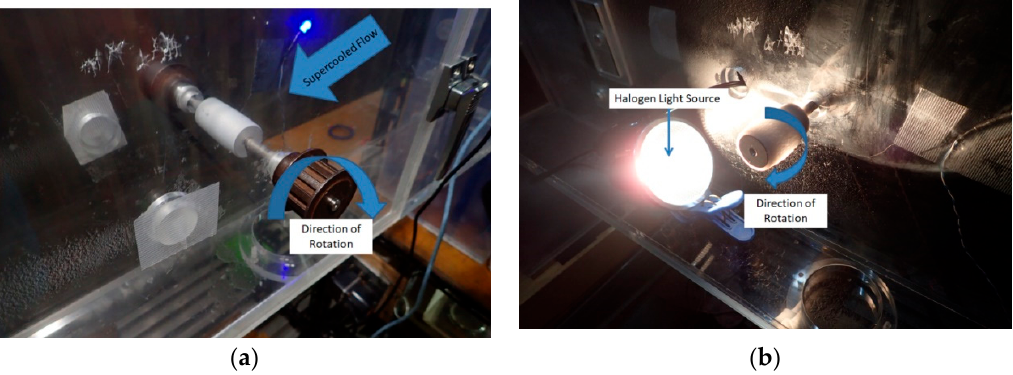
Figure 4. ( a ) Coating during supercooled airflow exposure and ( b ) radiation exposure.